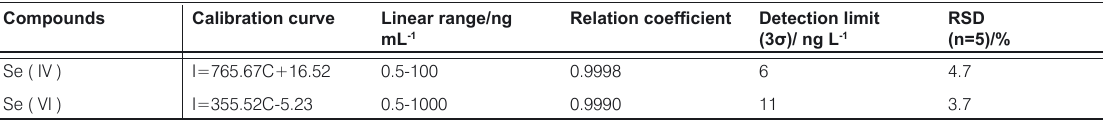
Table 1. The Standard calibration curve and liner range of selenium compounds.